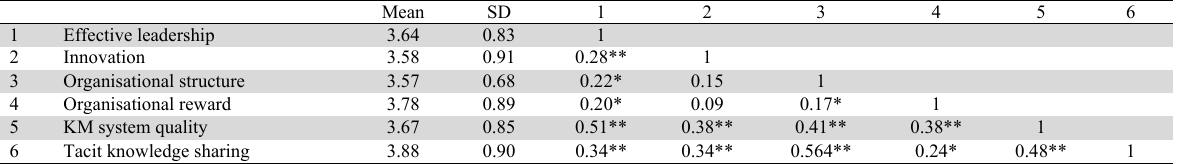
Simple regression